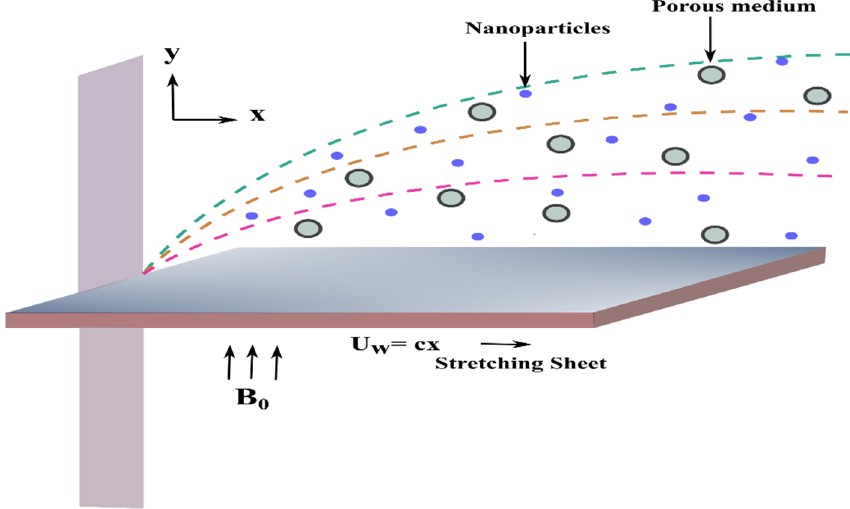
Figure 1. Flow geometry.